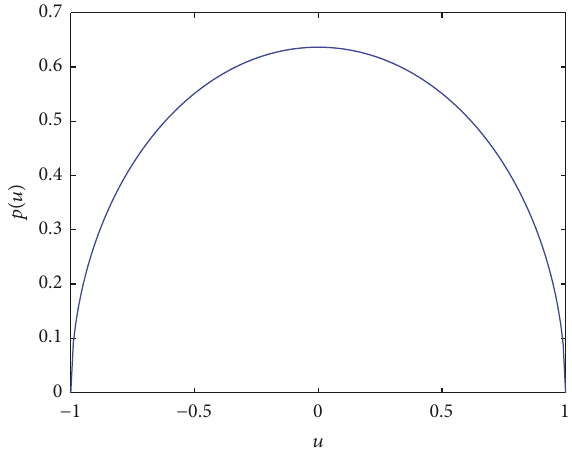
Figure 1: The Wigner semicircle PDF 𝑝(𝑢) curve for random variable 𝑢